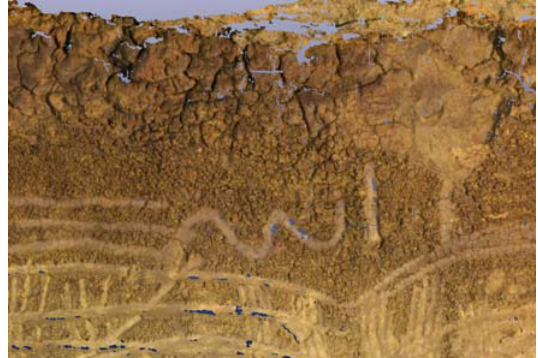
Figure 6. 3D textured raw model obtained by dense stereo matching from two panorama standpoints in front of the clay panel (the distance to object is 5m, focal length 85mm, pixel size in the object is less than 0,5mm, base/distance ratio is 0,4).